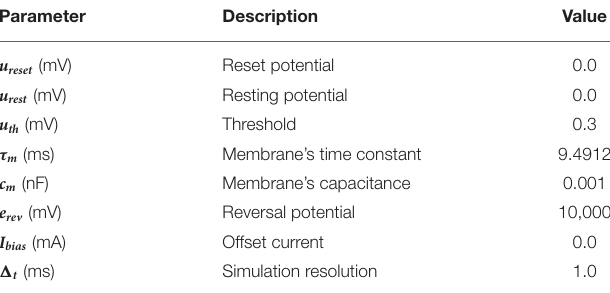
TABLE 1 | SpiNNaker simulation parameters for the proposed